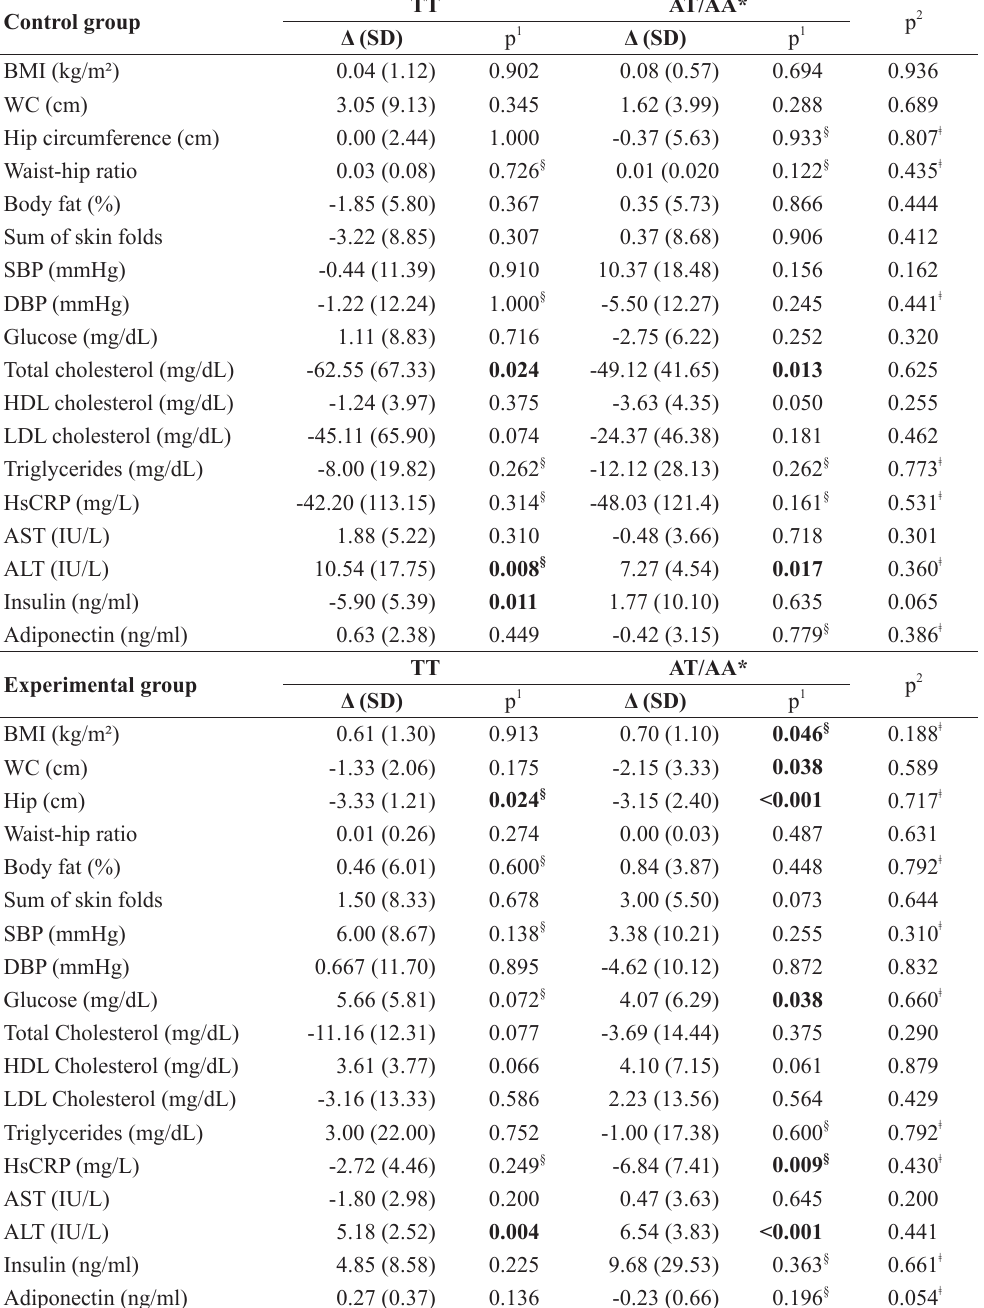
Genotype comparison of biochemical and anthropometric variables before and after 4 months of intervention in each group (control and experimental)